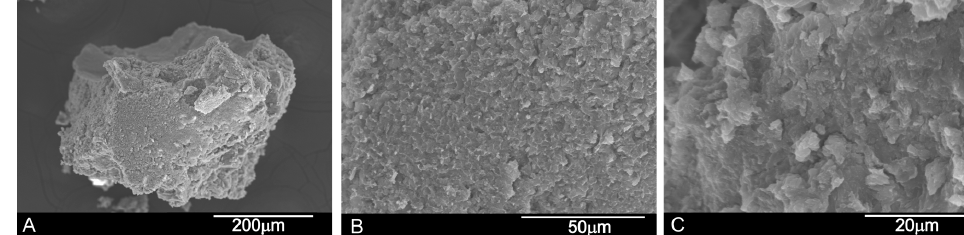
Figure 2. Scanning electron micrographs of Porcine HAs scaffolds deproteinized at low temperature (PBM): ( A ) low magnification image of the HA grafts; ( B ) high magnification image; and ( C ) details of the scaffold’s surface roughness.